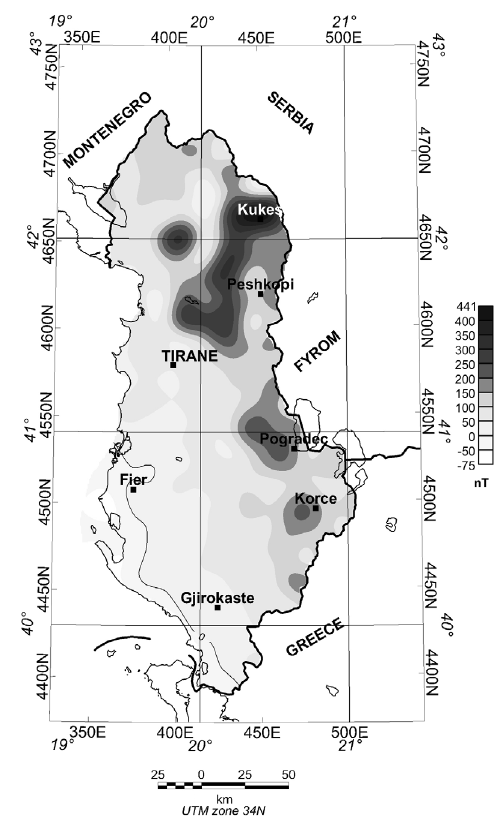
Fig. 6. The total magnetic field anomaly filtered by removing all wavelengths smaller then 25